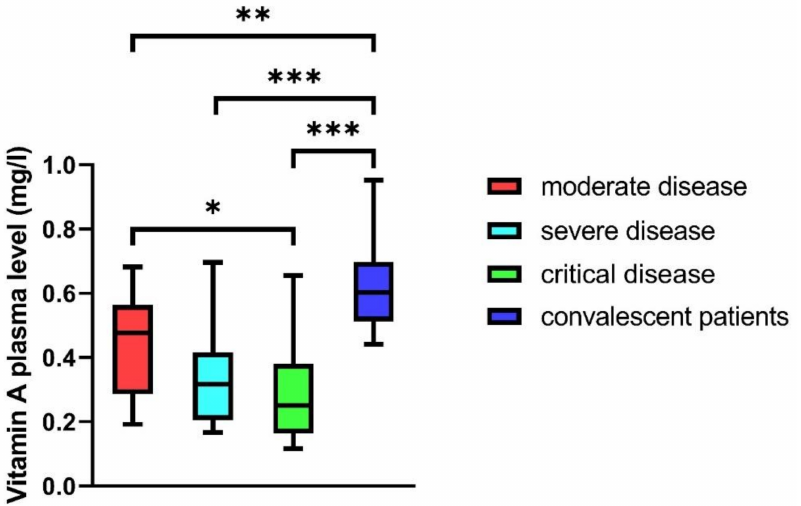
Figure 2. Vitamin A plasma levels in patients with moderate, severe, and critical disease, and in convalescent patients; the Wilcoxon rank test showed significant differences ( p < 0.001). Subgroups were tested for differences in the Bonferroni correction (* p < 0.05, ** p < 0.01, *** p < 0.001). Mann– Whitney U test was used to compare groups (* p < 0.05, ** p < 0.01, *** p <